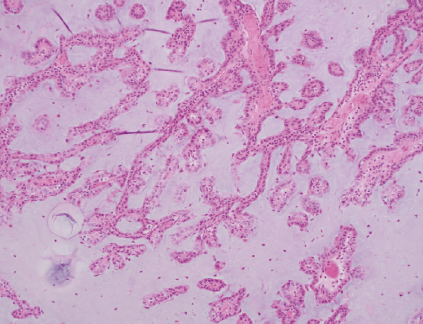
Figure 3: Papillary tumor fronds floating within a mucinous background (200x, H&E stain).